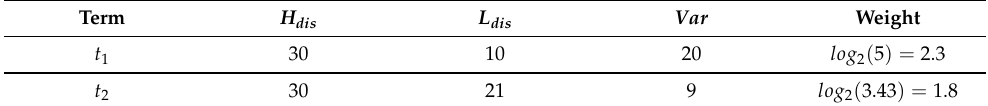
Table 5. Example 1: clarification of the advantage of using the rf factor.